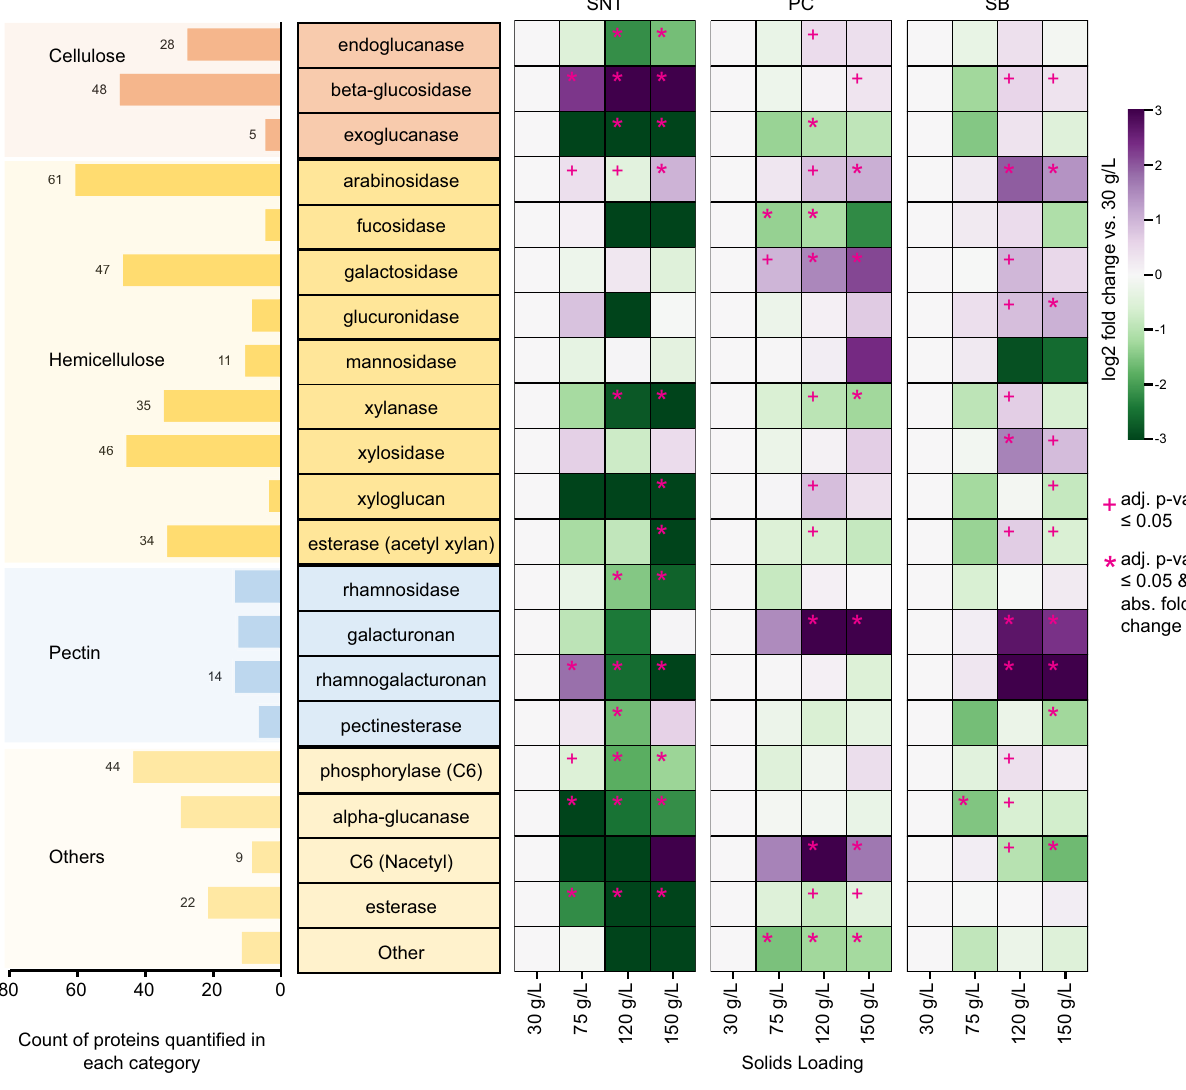
Fig. 3 Analysis of CAZyme functional categories at higher solids loadings. (left side) Enumeration of quanti fi ed unique CAZyme proteins across different CAZyme families (GH, CE, PL) after organizing them based on functional annotation as described in Supplementary Data 3. (right side) Heatmap depicting the change in aggregate abundance of CAZymes in each functional category across solids loadings for each fraction. Log 2 differences from 30 g/L solids in the respective fraction are shown. A two-tailed Welch ’ s t -test was performed with Benjamini Hochberg FDR correction for each solids loading versus the 30 g/L loading. + means adjusted (adj.) p -value ≤ 0.05 and * means adj. p -value ≤ 0.05 with absolute fold change ≥ 2× vs. respective 30 g/L condition. Exact p -values for each comparison are listed in Supplementary Data 6. SNT: supernatant, PC: planktonic cells, and SB: substrate bound fraction. Source data are provided as a Source Data fi